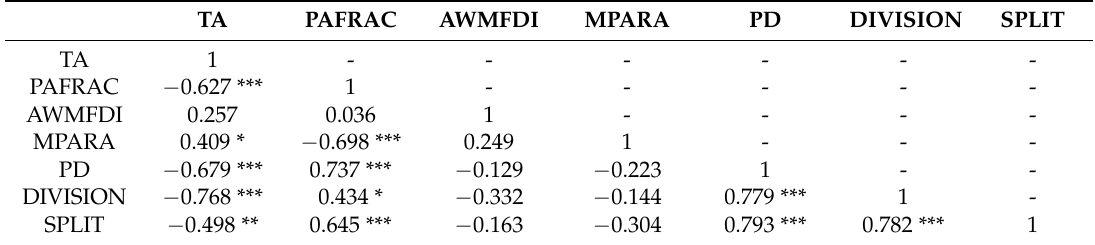
Table 4. Pearson’s correlation coefficients of the independent variables.